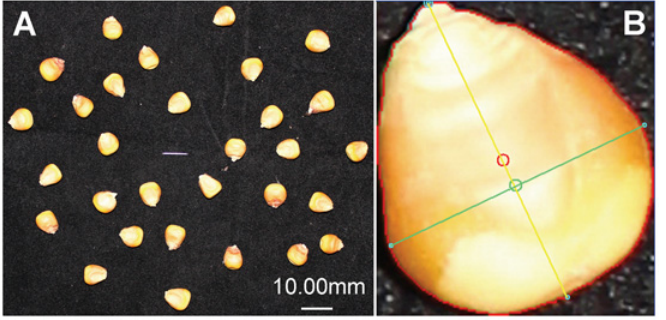
Fig 3. Images of kernel shape related traits detected by SmartGrain . (A) The loading image for SmartGrain . The gray wire in the center of the image is used as the reference length. (B) KSRTs recognized by SmartGrain . The red outline can be used for calculating PL and KA (areas within the red line); The yellow and green lines indicate the KL and KW, respectively, and can also be used for calculating LWR and CS; The small red circle and green circle represent the center of gravity and the intersection of length and width, respectively, as evaluated by SmartGrain . These values are not included in our analysis.